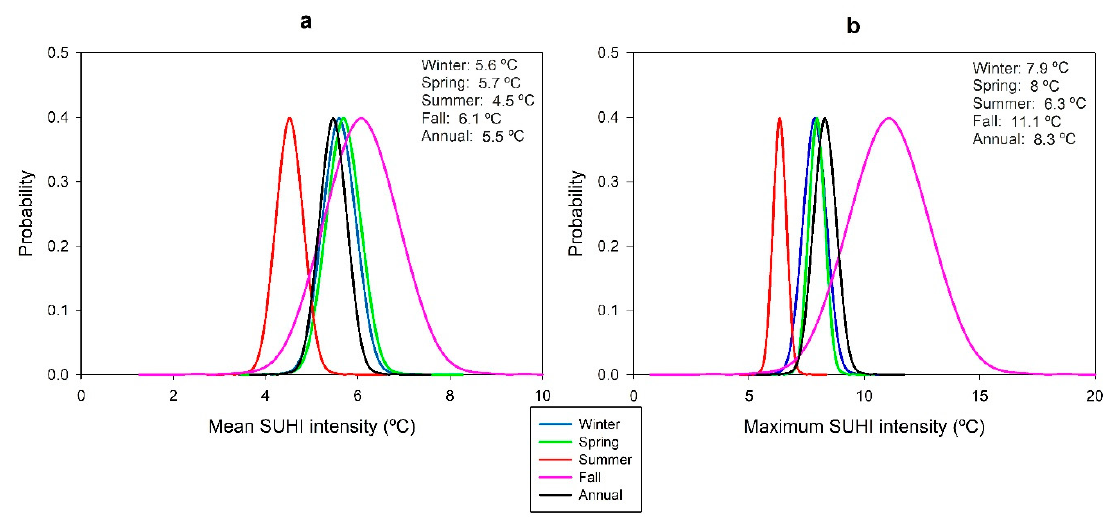
Figure 3. Probability distribution function (pdf) of the mean (panel a ) and maximum SUHI (panel b ) calculated on a seasonal basis for Greater Cairo between 2003 and 2019. The provided numbers indicate the mean of each season.